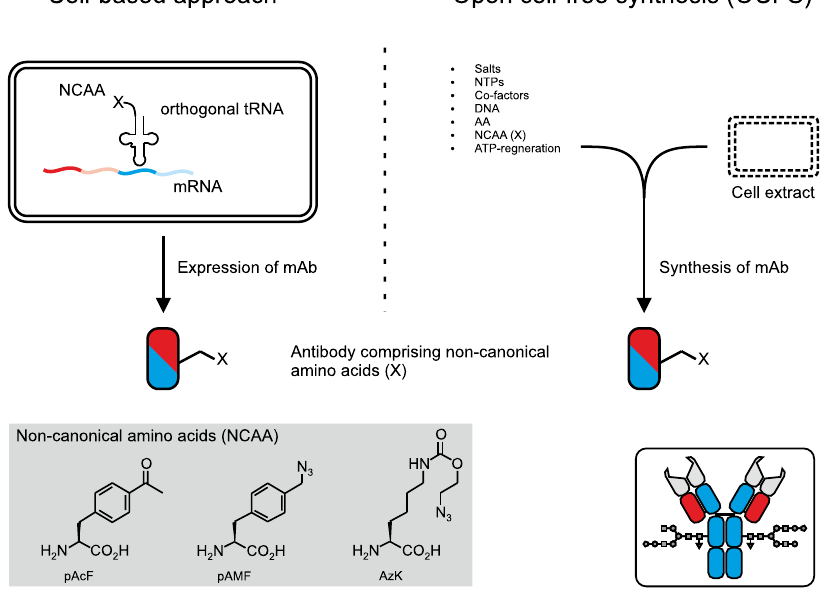
Figure 3. Two different approaches can be employed to incorporate non-canonical amino acids (NCAA) such as p -acetylphenylalanine (pAcF), p -azidomethyl- L -phenylalanine (pAMF) and azido-lysine (AzK) into an antibody. The cell-based approach uses an orthogonal tRNA/aminoacyl-tRNA synthetase pair to generate a tRNA that carries a NCAA (X) and, hence, an orthogonal functionality is integrated into the antibody. On the contrary, the open cell-free synthesis (OCFS) is used to synthesize, rather than to express, the protein in a cell free environment. It requires cell extract (provides essential organelles), salts, nucleoside triphosphates (NTPs), co-factors, the corresponding DNA, amino acids (AA), NCAA and an energy regeneration